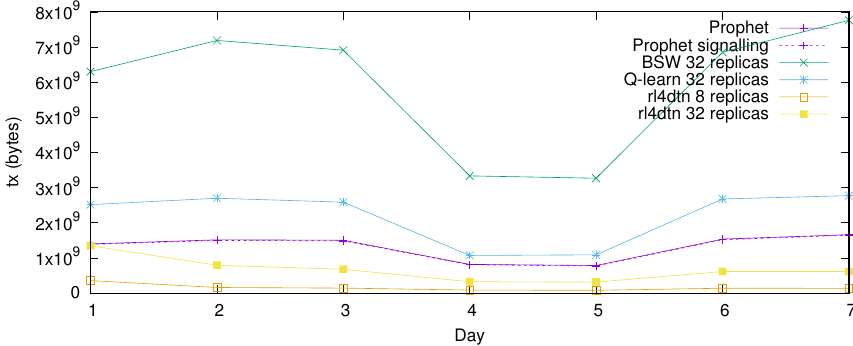
Figure 8. Total data transmitted in the